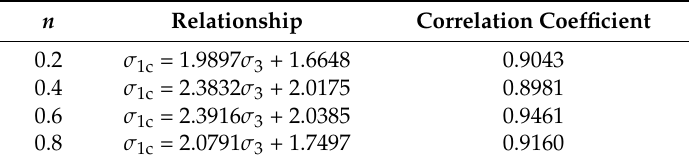
Figure 3. Relationship between the compressive strength and confining pressure. Table 4. Relationships between the compressive strength and confining pressure.